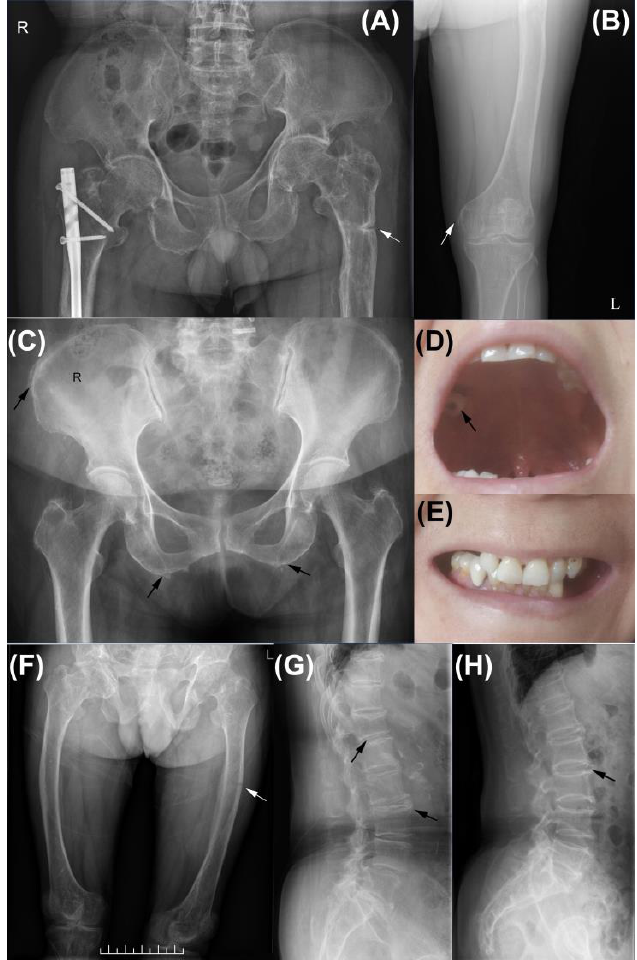
Figure 1. Radiological and dental findings of patients. ( A ) PT-13 previously experienced an atrau- matic femoral fracture and received internal fixation, and a pseudofracture was identified on his left femur (white arrow); ( B ) calcium pyrophosphate dihydrate deposition disease (CPPD) of the left knee in PT-13; ( C ) pelvic CPPD found in PT-12, calcium pyrophosphate deposition was identified (black arrow); ( D ) sparse teeth, a dental decay, and ( E ) hypocalcified enamel were prominent in FAM2-3; ( F ) bowling of bilateral femurs and a pseudofracure (white arrow) were identified in FAM1-3; vertebral CPPD was identified in PT-12 ( G ) and PT-13 ( H ).